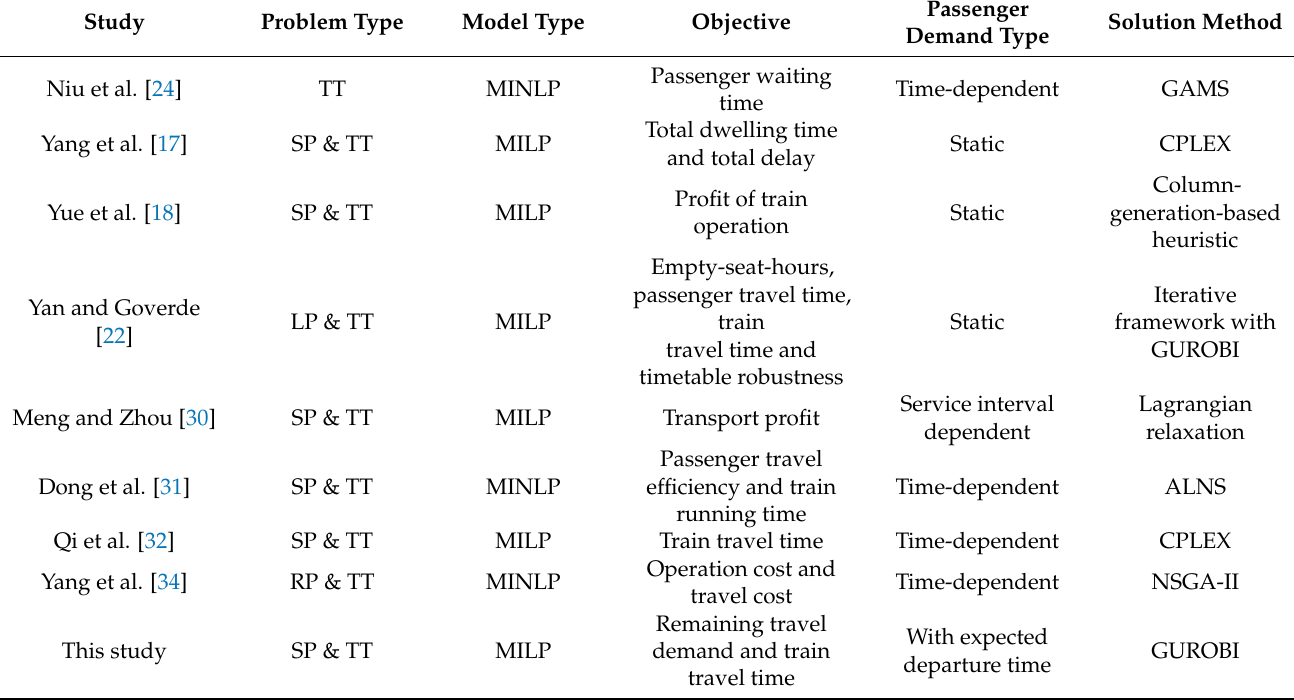
Table 1. Summary of relevant